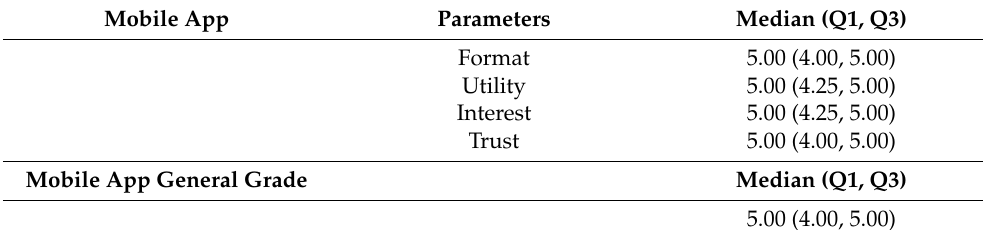
Table 3. Quantitative evaluation of the mobile